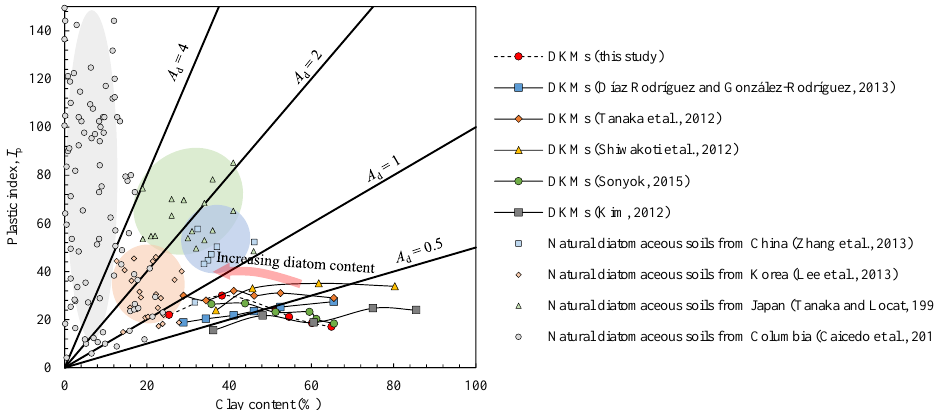
Figure 8. Relationship between I P and clay fraction for different DKM samples. Data sources: DKMs [6,12,31,32,34], Natural diatomaceous soils [2 – 5].